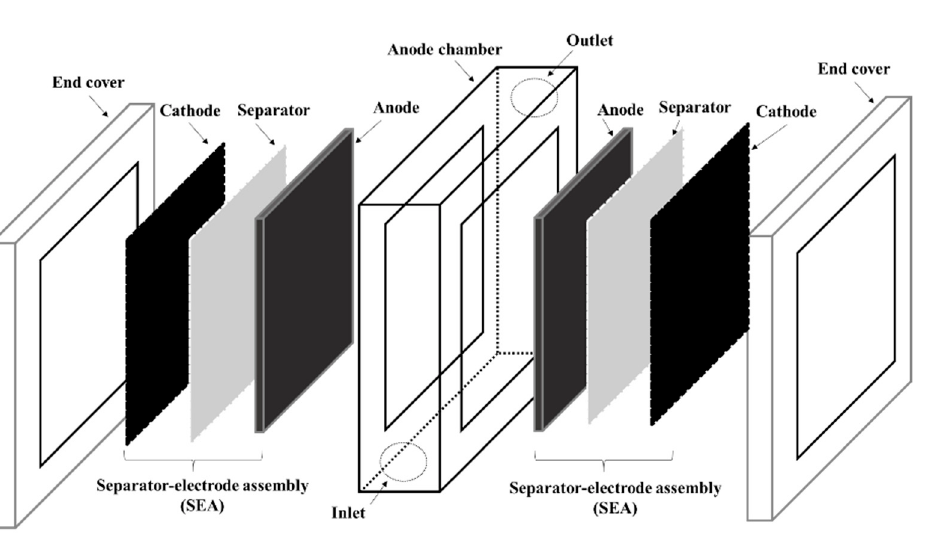
Figure 1. The schematic diagram of microbial fuel cell in this study. Table 1. Configuration of small (S-), medium (M-), and large (L-) microbial fuel cells (MFCs) used in a stack system.